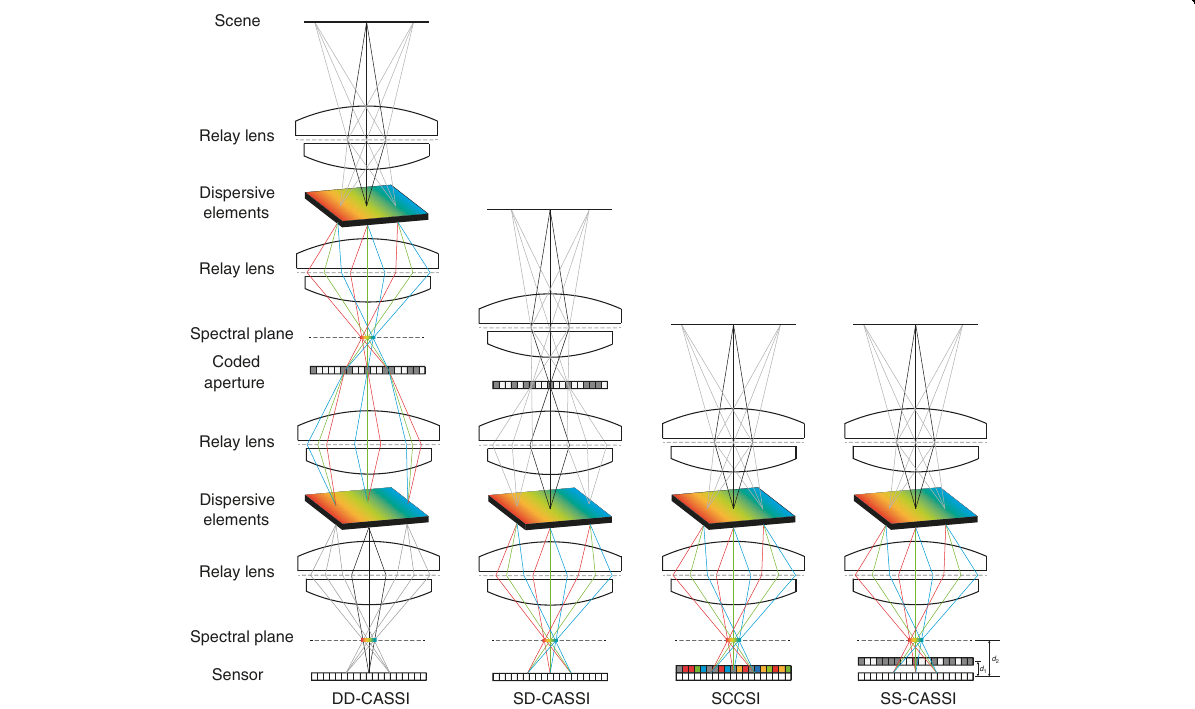
Fig. 2 Illustration of four CASSI architectures. In DD-CASSI architecture, the spectral scene experiences a shearing-coding-unshearing procedure. In SD-CASSI, the diffraction grating before the coded aperture is removed, therefore it becomes a coding-shearing process. In SCCSI, the coded aperture is placed behind the dispersive element and the spectral data will experience a shearing-coding procedure. In SS-CASSI, coded aperture position becomes fl exible between spectral plane and camera sensor, where the ratio ( d 1 + d 2 )/ d 2 determines the extent of spectral encoding